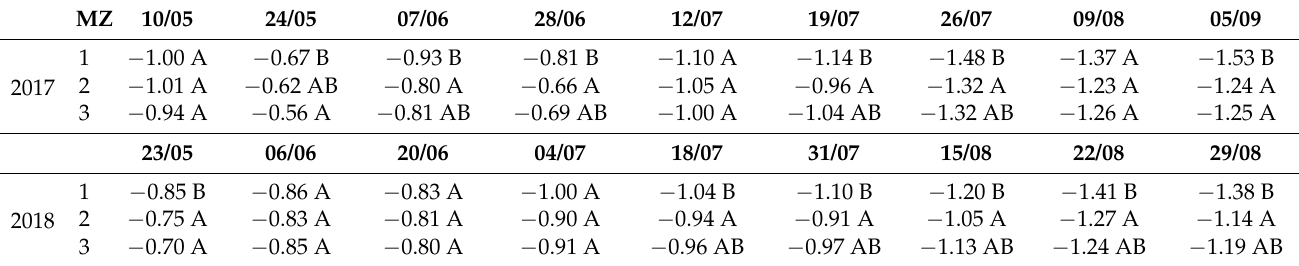
Table 2. Midday stem water potential in each management zone (MZ) during 2017 and 2018. Each value is the mean of 22, 28 and 10 replicates for MZ 1, 2 and 3, respectively. The value of each replicate was the average of the measurements of two adjacent sample vines. Data were analyzed by ANOVA. Different letters represent significant differences among MZs, means were separated using the Tukey–Kramer HSD test ( α = 0.05).